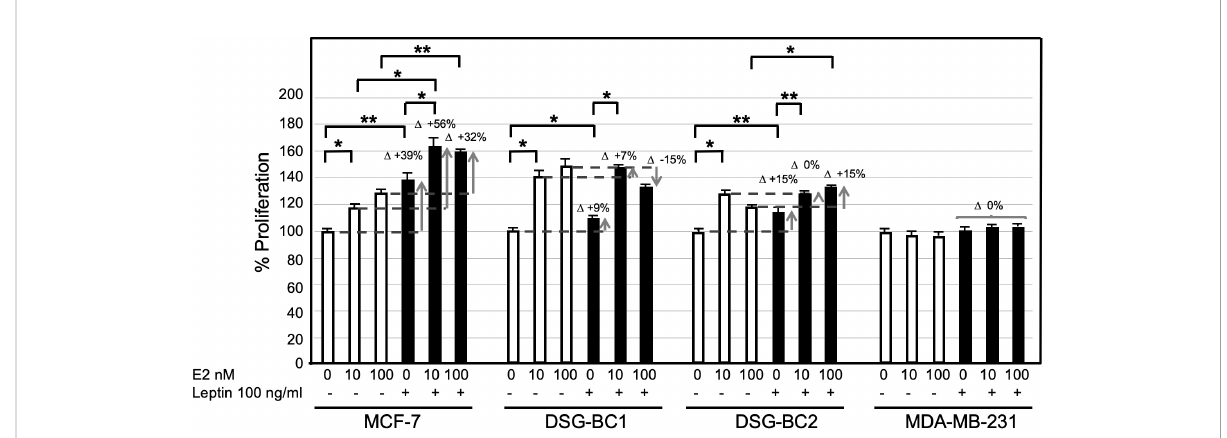
FIGURE 10 Breast cancer cells derived from an obese patient are sensitized to estrogen-proliferation by chronic exposure to leptin. The indicated 4 breast cancer cell lines were cultured as described in materials and methods: treated for 4 days with leptin (100 ng/ml) changed to medium without phenol red and supplemented with lipid free serum for 24 hours before the fi nal stimulation with estradiol (E2) at the indicated concentrations for 48 hrs. Control cultures received no leptin stimulation (empty bars). Sensitization is depicted at the increase in proliferative response (D+). Values are the average of triplicates +/- standard deviation; n = 3. Brackets indicate comparisons with p value < 0.05 (*) or a p value < 0.01